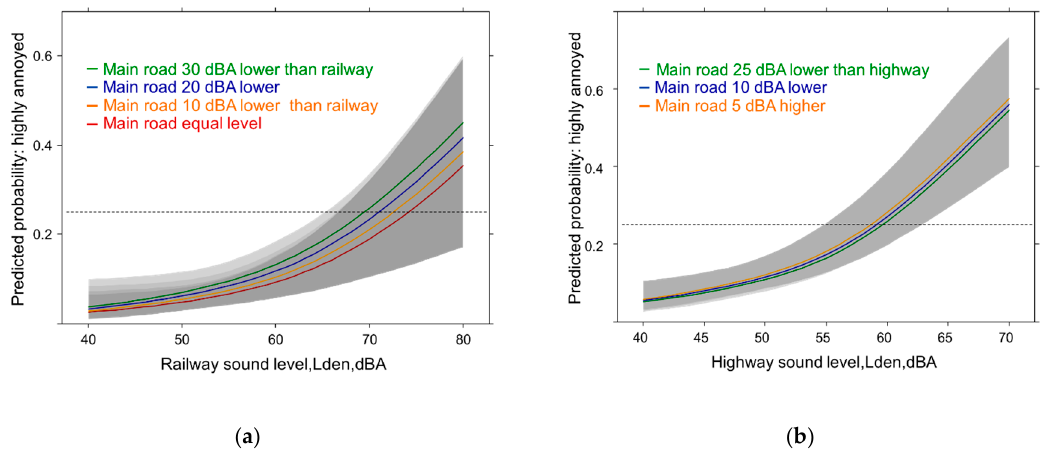
Figure 10. Predicted proportion of high source annoyance associated with level differences to the other source (in dBA). ( a ) Railway & main road; ( b ) Highway & main road. Adjusted for age, sex, education, noise sensitivity, health status and the other sound source difference.